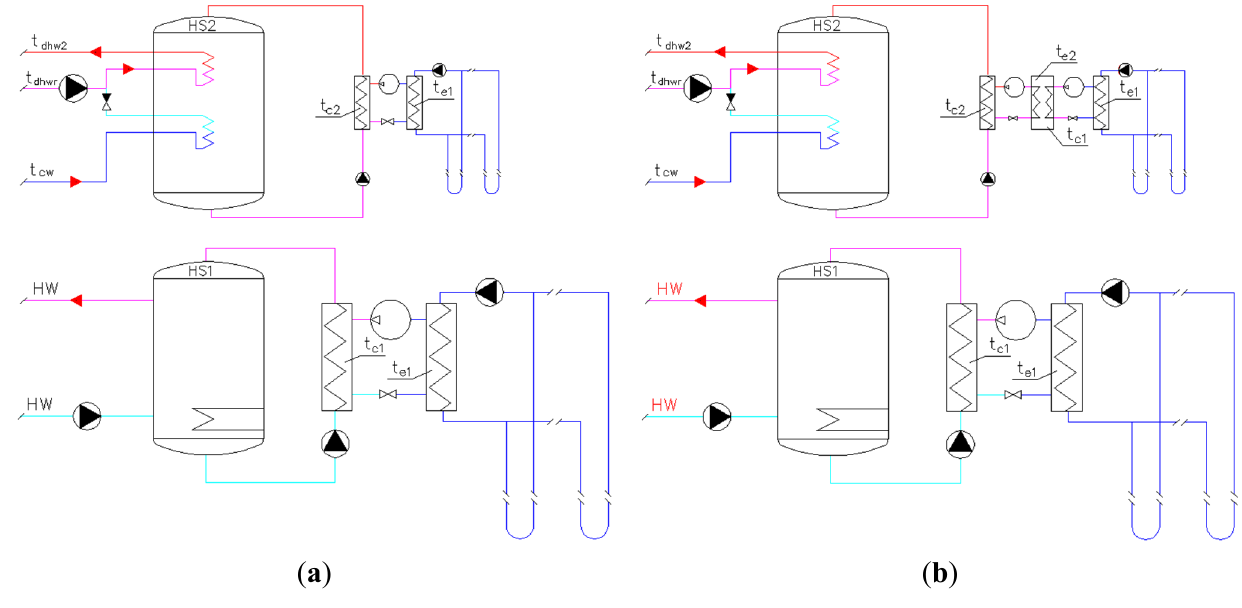
Figure 3. DHW production: ( a ) System 5 and ( b ) System